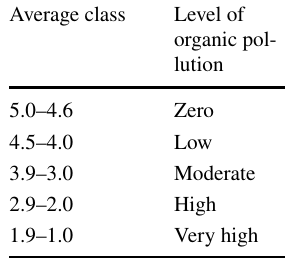
Table 11 Water quality status based on average class (Benkhedda et al. 2014)